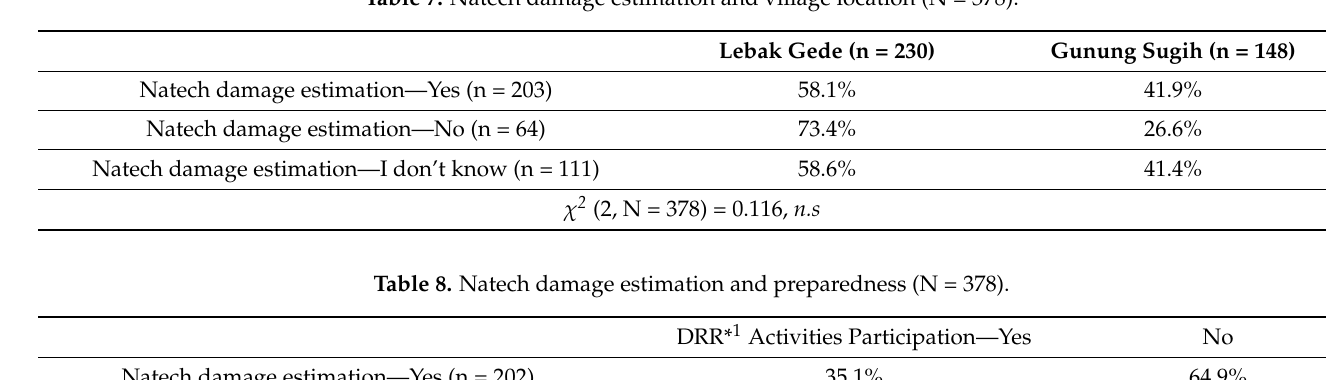
Table 7. Natech damage estimation and village location (N = 378).